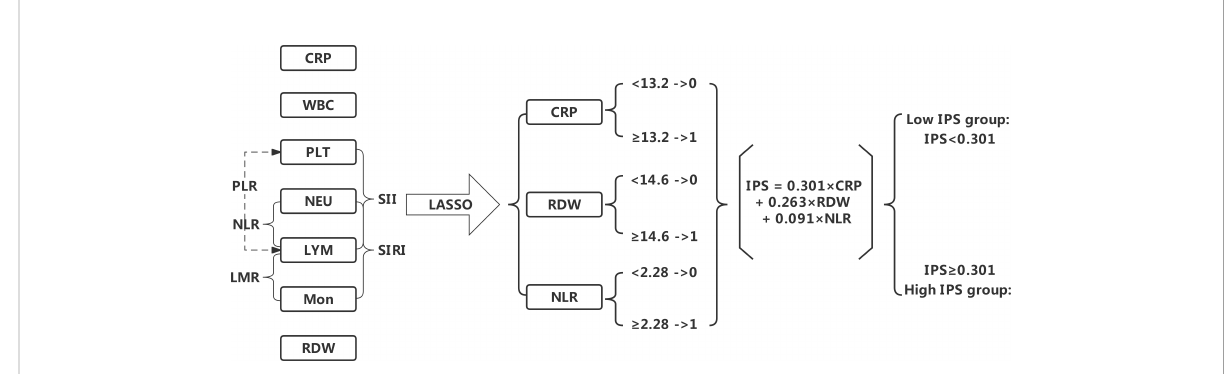
FIGURE 4 Flow chart for the development of the in fl ammatory prognostic scoring (IPS).